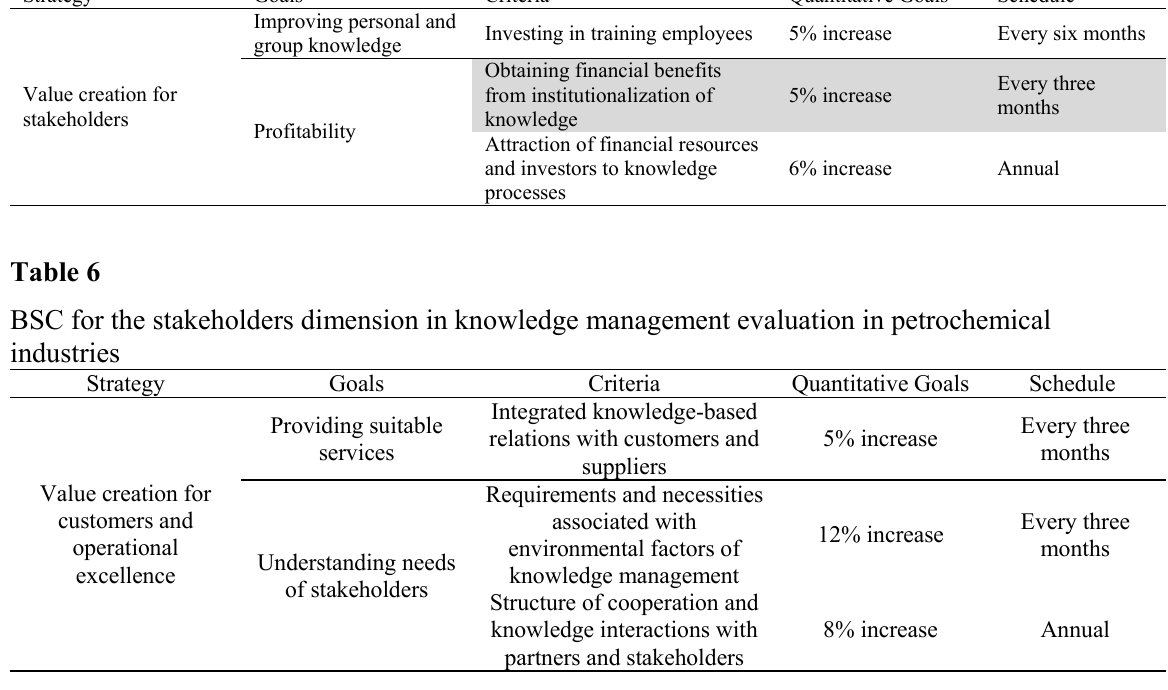
Schedule Quantitative Goals Criteria Goals Strategy